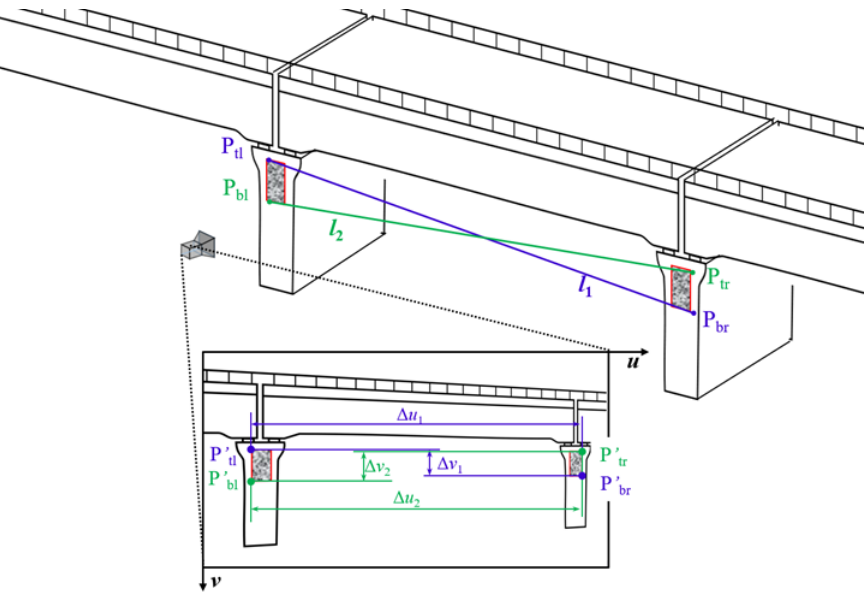
Figure 5. Calculation of size factor.